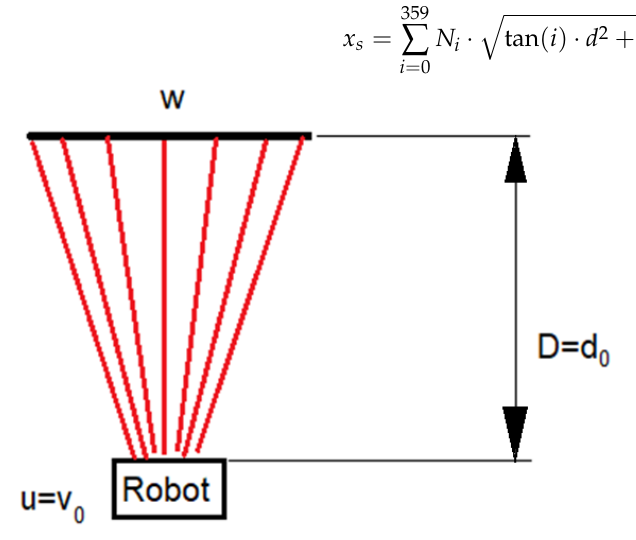
Figure 12. Representation of the cost function simulation. Each member represents one laser beam since there are 360 laser beams in total. In the formula, N i indicates whether a given laser beam has reached the obstacle because only the laser beam that has reached the obstacle can be used to measure distance information. d is the distance from the wall. Equation (13) shows whether a given laser beam will reach the